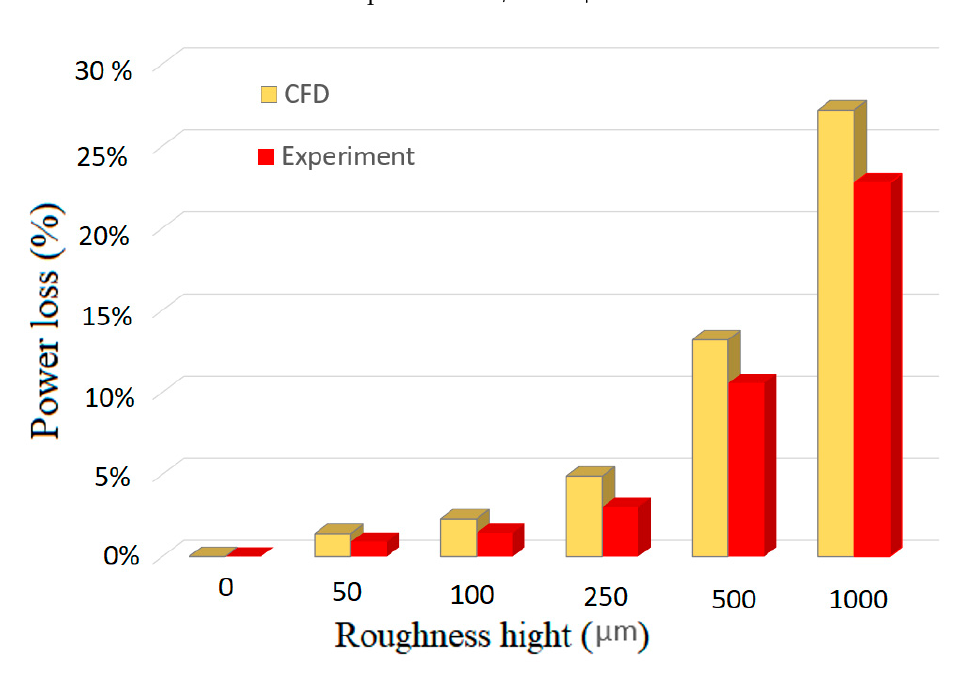
Figure 14. Percentage of power loss of the DH turbine with NACA 0015 airfoil for six different roughness heights ( U w = 1.0 m/s).